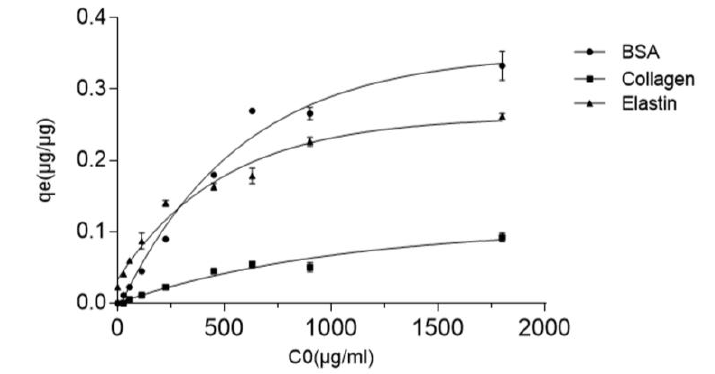
Figure 3. Effect on the GO adsorption capacity (qe) of the initial concentration (C 0 ) of BSA, collagen and elastin at 37 °C after 2 h of